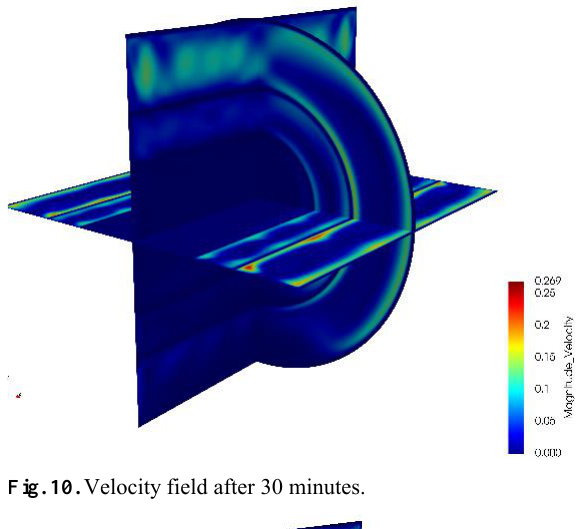
Fig. 9. Velocity field after 15 minutes .